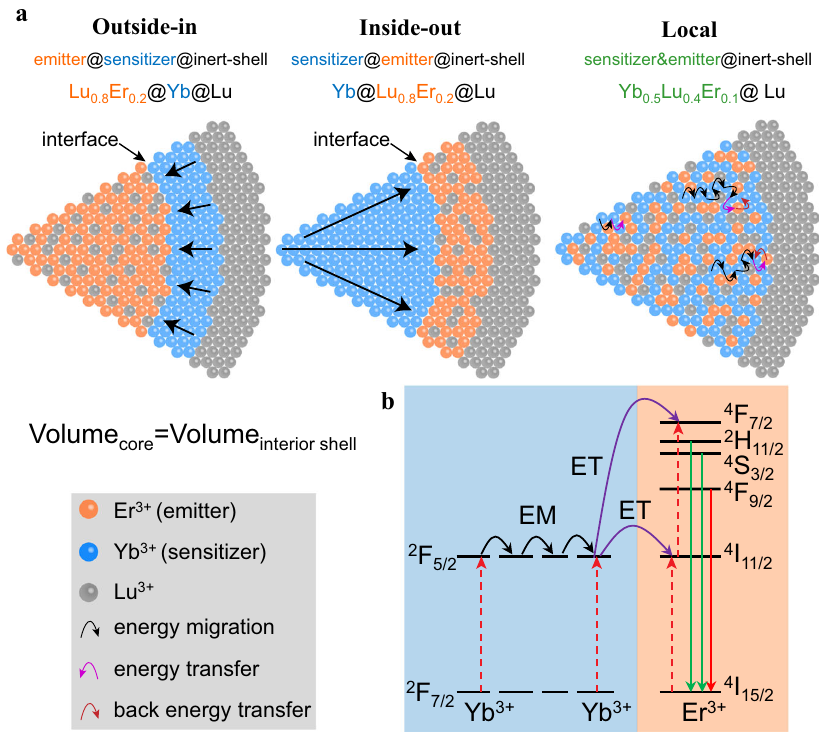
Fig.1|Schematicdiagramsofdesigns.a Schematicdiagramsofoutside-in,inside- outandlocalenergytransferarchitectures.Thestraightblackarrowsrepresentthe principle energy migration direction of outside-in and inside-out architecture with distinct interface. Orange ball represents Er 3+ , blue ball Yb 3+ , gray ball Lu 3+ ; black curved arrows, purple curved arrows and red curved arrows depicts the energy migration, energy transfer and back energy transfer, respectively. b Schematic diagrams of energy transfer from Yb 3+ (sensitizer) to Er 3+ (emitter) and